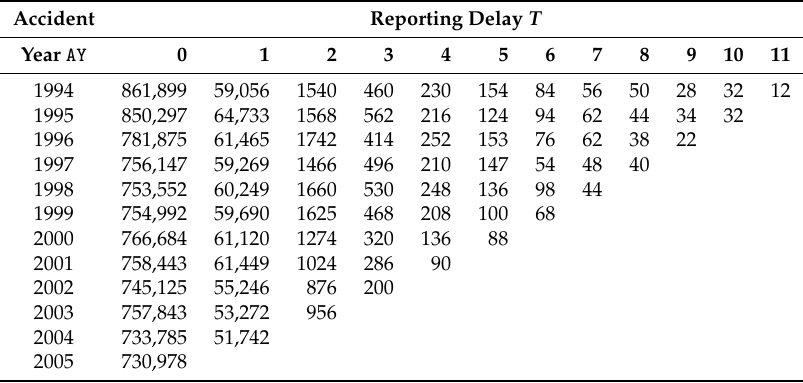
Table 2. Triangle of reported claims of the real data.